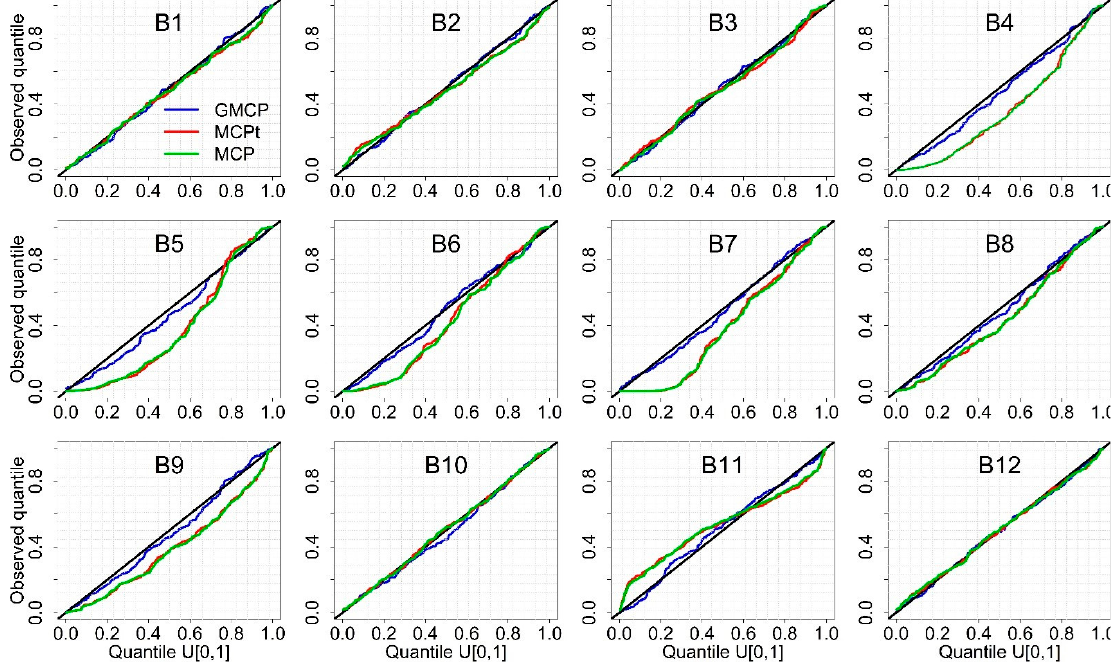
Figure 5. Predictive PQQ plot of the three evaluated post-processors and 12 MOPEX catchments during the validation period